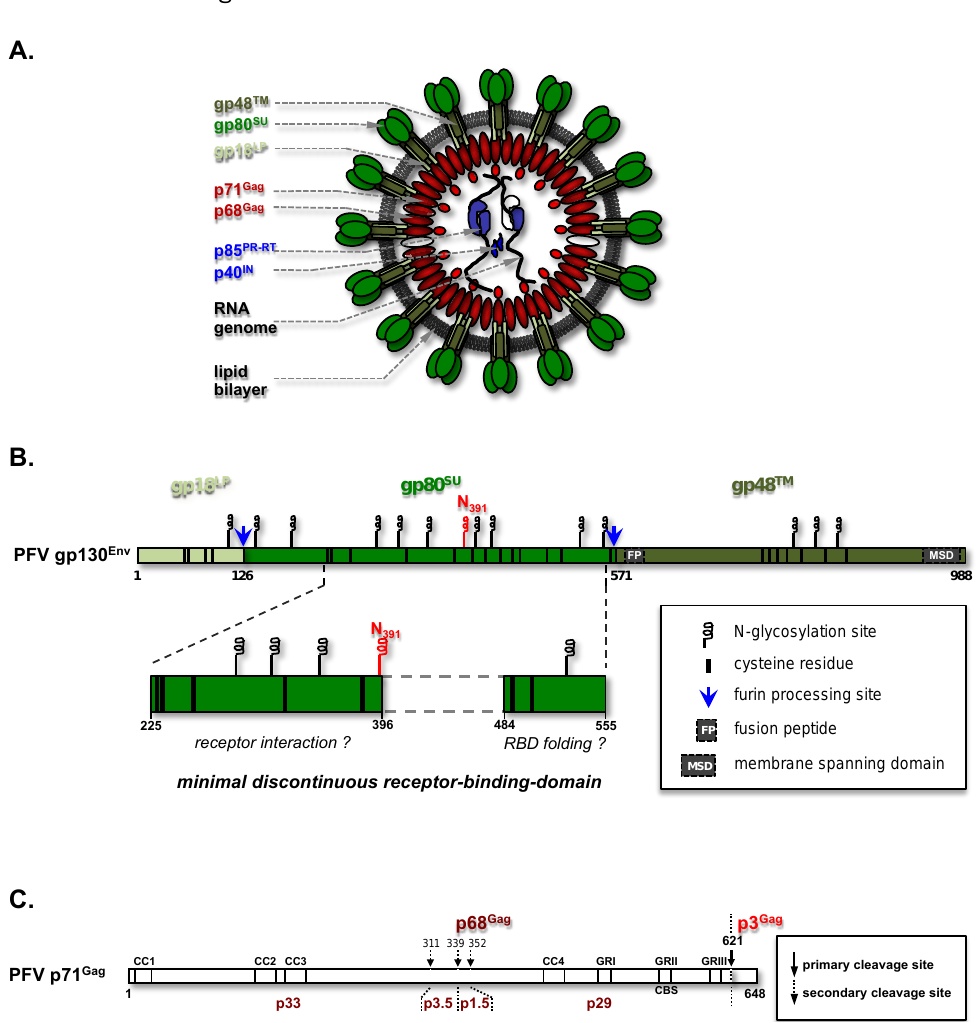
Figure 1. Particle composition and structural protein organization of PFV. ( A ) Schematic outline of a PFV particle. Two copies of the single-stranded RNA genome are encapsidated, which in the virus-producing cell is already reverse transcribed into DNA in a significant fraction of virions. The viral nucleic acids as well as pol-encoded protease-reverse-transcriptase (PR-RT) and integrase enzymes are surrounded by a protein shell, composed of gag-encoded capsid protein precursor (p71 Gag ) and its large processing product (p68 Gag ). During budding a host-cell derived lipid bilayer is acquired, which harbors the mature viral glycoprotein complex containing leader peptide (gp18 LP ), surface (gp80 SU ), and transmembrane (gp48 TM ) subunits. ( B ) Schematic organization of the PFV glycoprotein precursor protein. The individual mature glycoprotein subunits are indicated and color-coded. Below the minimal, discontinuous receptor-binding-domain characterized within the SU subunit is enlarged. N-glycosylation sites, cysteine residues and furin processing sites are indicated. Numbers given below indicate amino acid positions. ( C ) Schematic organization of the PFV capsid protein precursor protein. The individual mature products derived by viral protease-mediated cleavage at primary or secondary processing sites (numbers given above indicate amino acid positions) are indicated. Functional domains characterized within the Gag protein are marked. CC: putative coiled-coil motif; GR: glycine-arginine rich box; CBS: chromatin binding